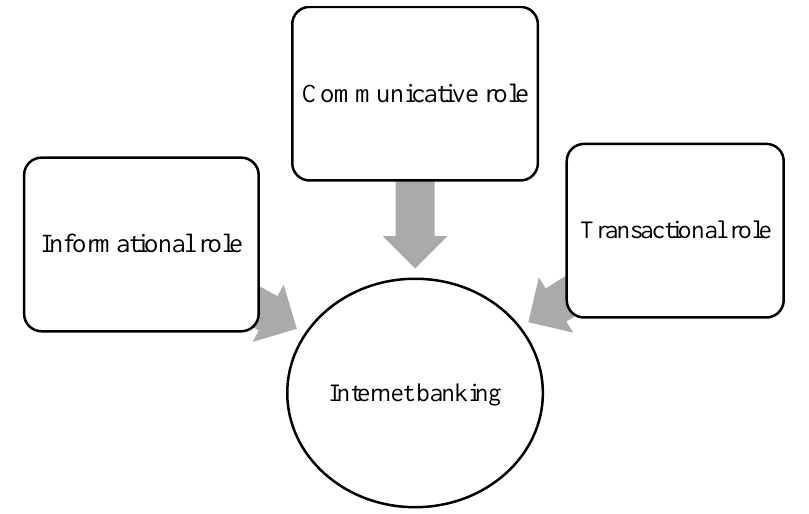
Figure 1: The three functional roles of Internet banking